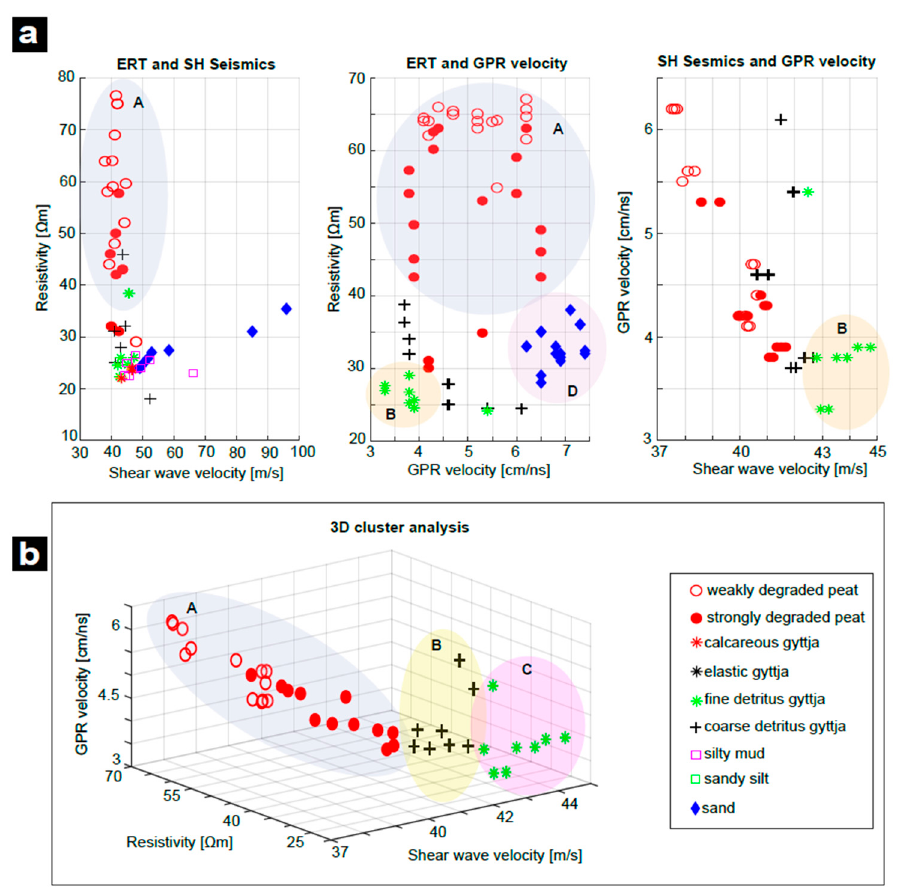
Figure 9. ( a ) Relation between geophysical properties resulting from the computation. From left to right: scatter plots of resistivity vs. seismic velocity (uppermost 3 m), resistivity vs.GPR velocities derived from the guided wave measurements (uppermost 2 m), and GPR velocities vs. seismic velocity (uppermost 2 m); ( b ) 3D cluster analysis considering the three properties. The different sediments are displayed with different symbols and colors.